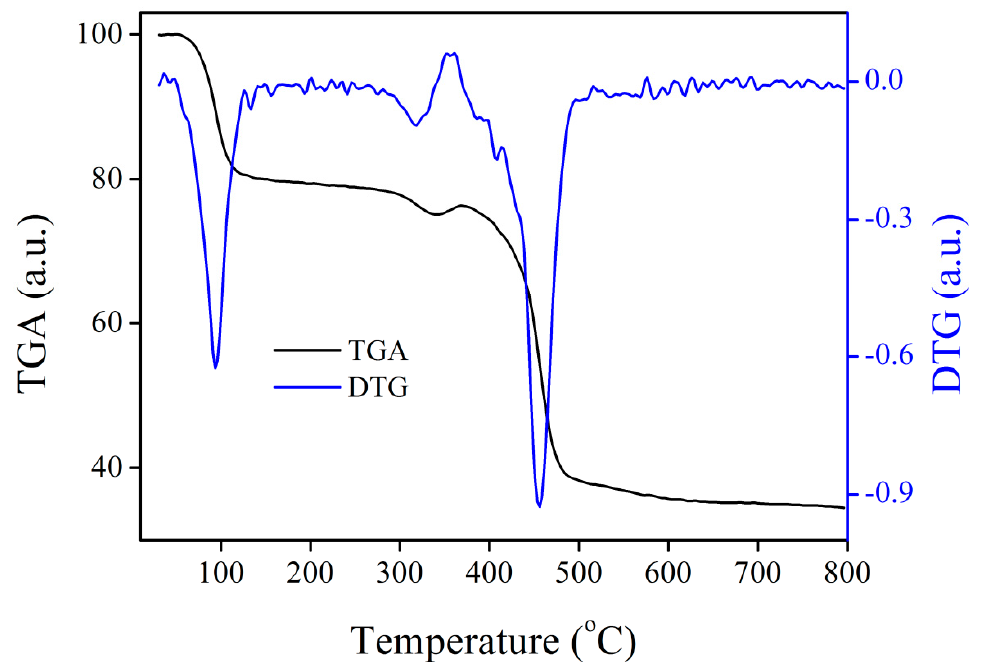
Figure 4. Thermal dynamics of RS6h@EuBTC.